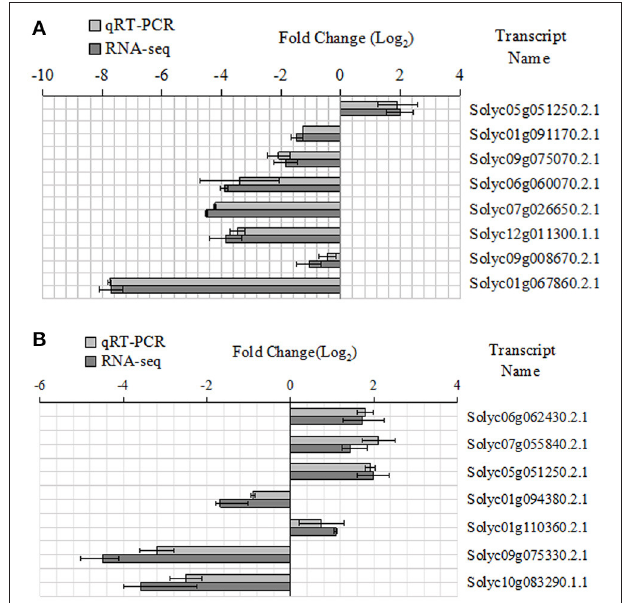
FIGURE 5 | Expression patterns of the different genes between the qRT-PCR and RNA-seq. (A) Amino acid metabolic pathway, (B) Carbohydrate metabolic